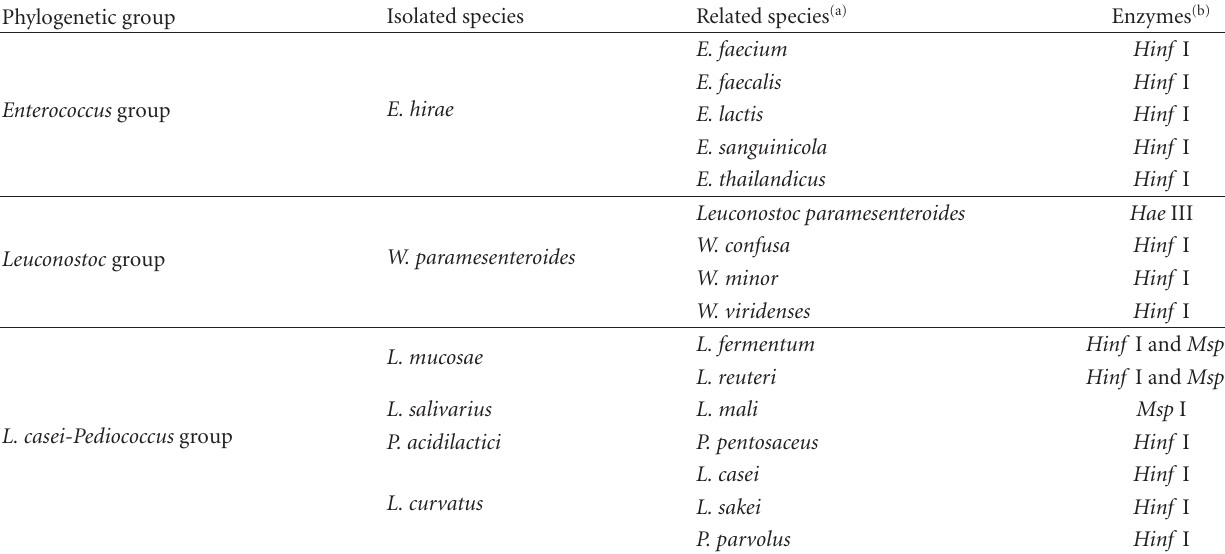
Table 3: In silico